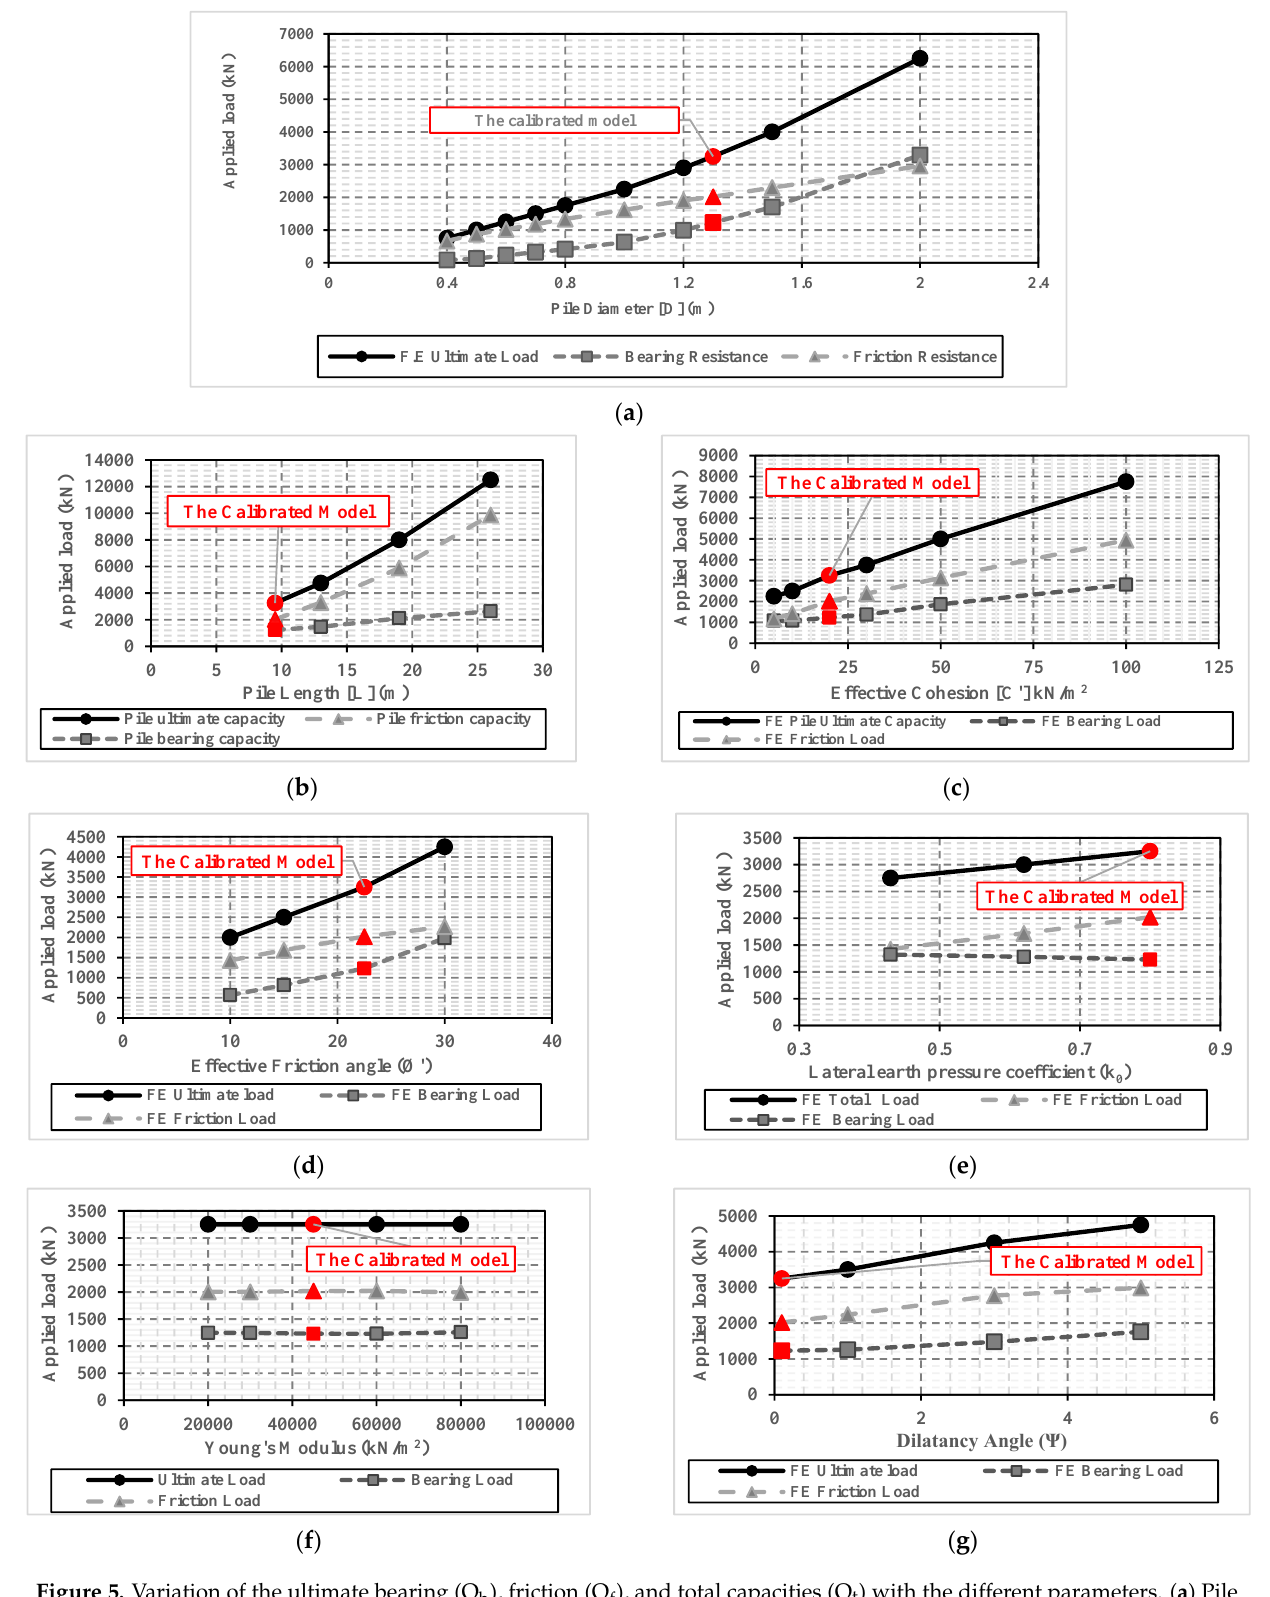
Figure 5. Variation of the ultimate bearing (Q b ), friction (Q f ), and total capacities (Q t ) with the different parameters. ( a ) Pile diameter (D). ( b ) Pile length (L). ( c ) Soil effective cohesion (c’). ( d ) Effective friction angle (Ø’). ( e ) Lateral earth pressure coefficient (K 0 ). ( f ) Young’s modulus (E s ). ( g ) Soil dilatancy ( Ψ ).